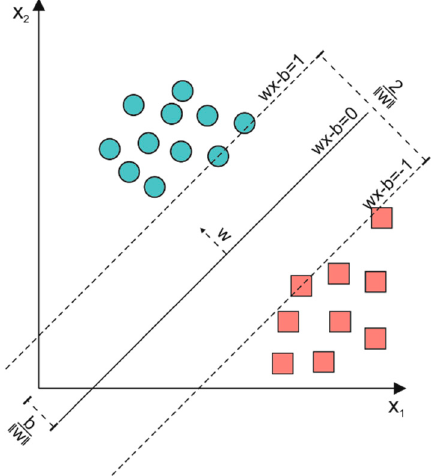
Figure 1. Example of a support vector machine (SVM). Circles and squares represent features related to two different classes. The distance 2/ ‖ w ‖ is the defined margin.